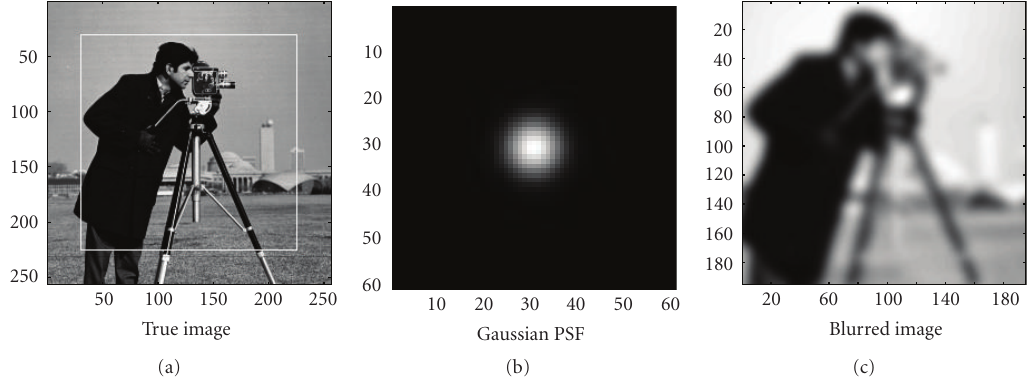
Figure 3: Test I: true image, Gaussian PSF, and the blurred image without